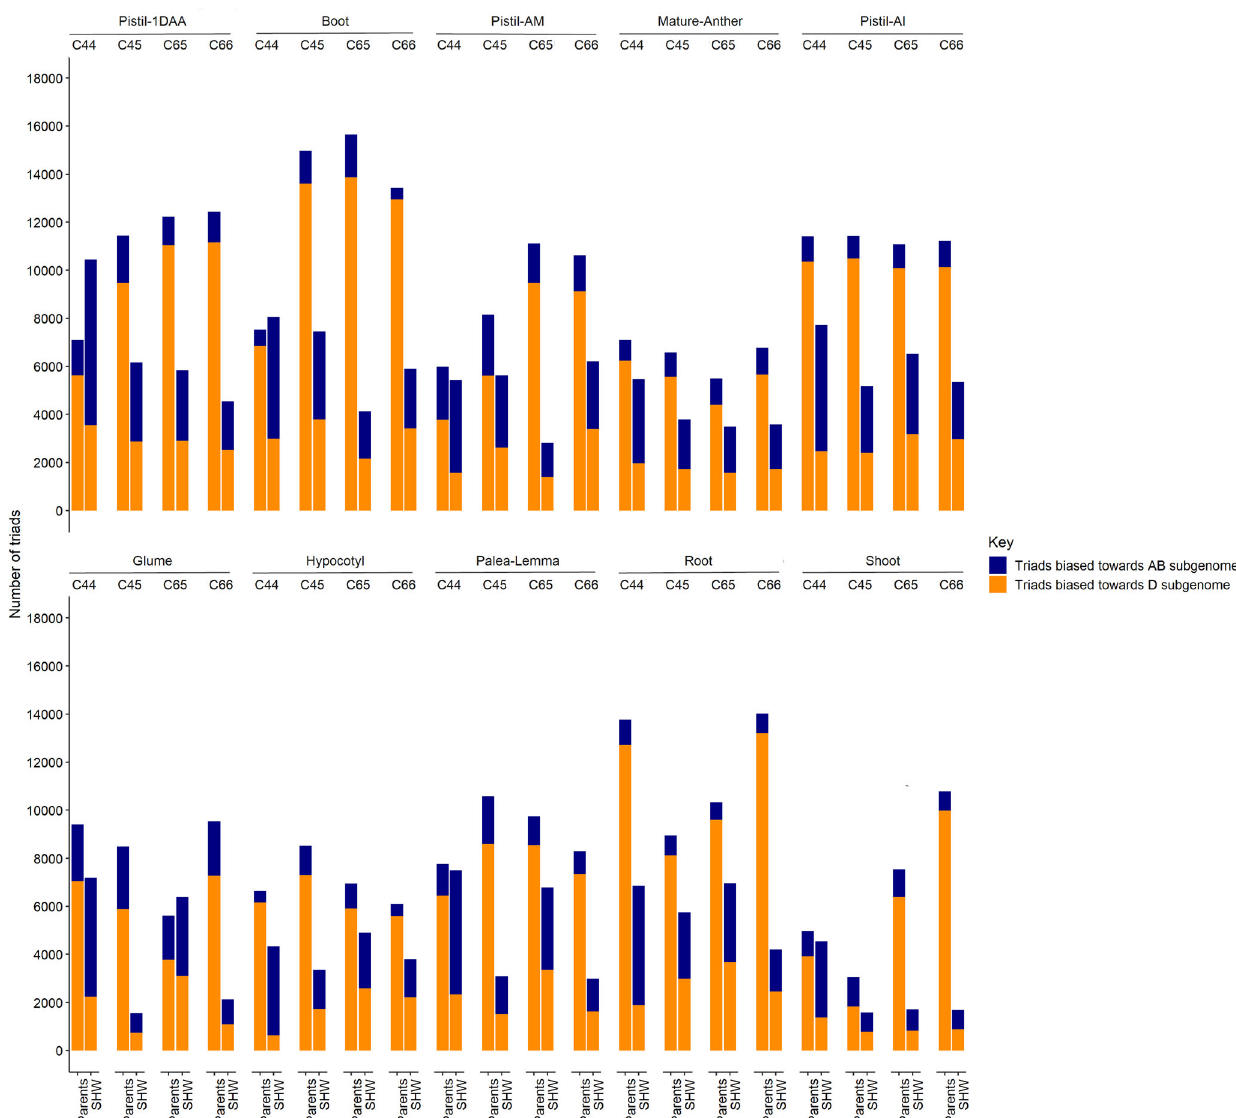
Fig. 1 Number of triads showing signi fi cant bias towards AB and D subgenomes in all four SHW lines — C44, C45, C65 and C66 and in the natural state of expression in their parents. The navy blue and dark orange bars represent the number of triads showing signi fi cant expression bias towards AB and D subgenomes, respectively. Pistil-1DAA pistil-one day after anthesis, Pistil-AM pistil — when anthers are at mature stage, Pistil-AI pistil — when anthers are at immature stage, Boot head at boot